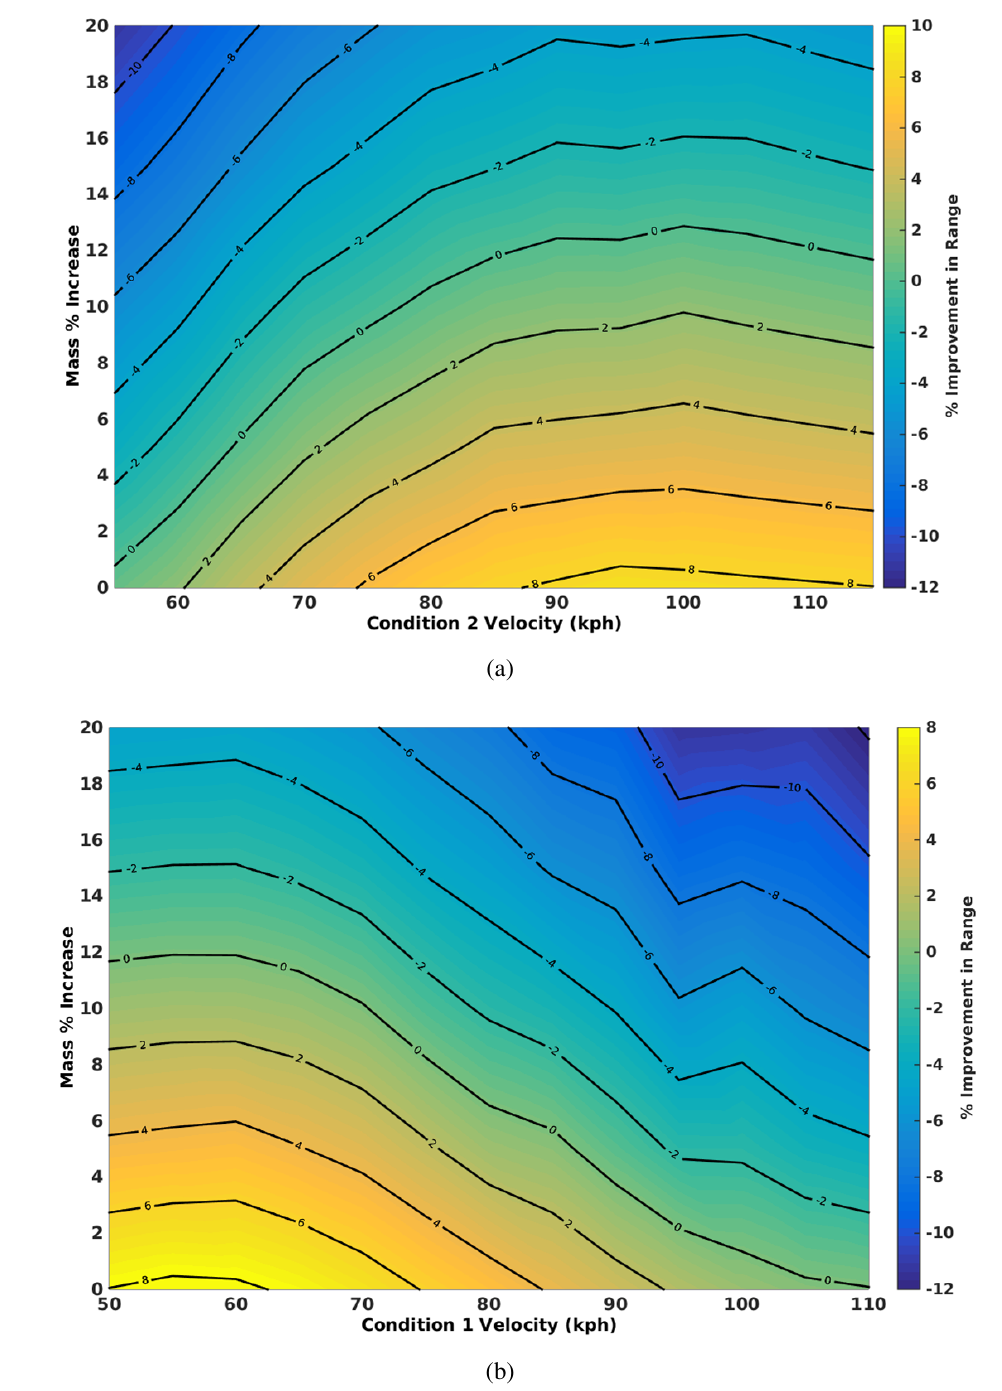
Figure 18. Effect of mass penalty on aerodynamic efficiency for optimum span with camber over variable speed ranges normalised to the baseline camber design. ( a ) Aerodynamic efficiency for low speed fixed at 50 kph; ( b ) aerodynamic efficiency for high speed fixed at 115